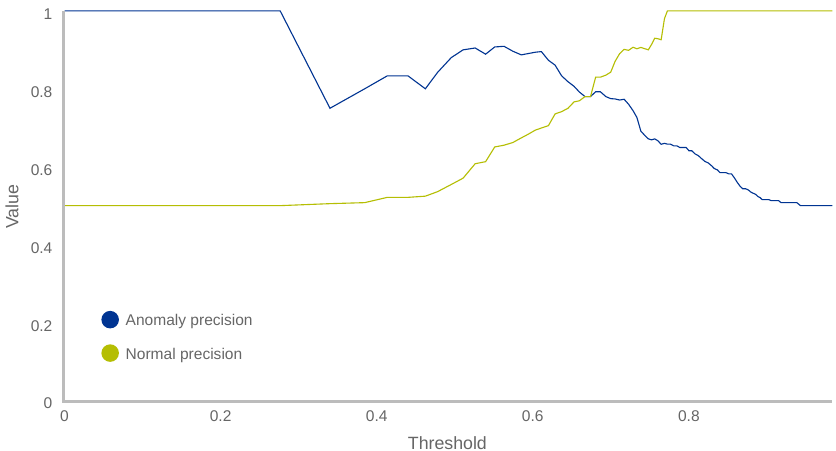
Figure 6. Precision curves on both normal and anomalous behaviours.